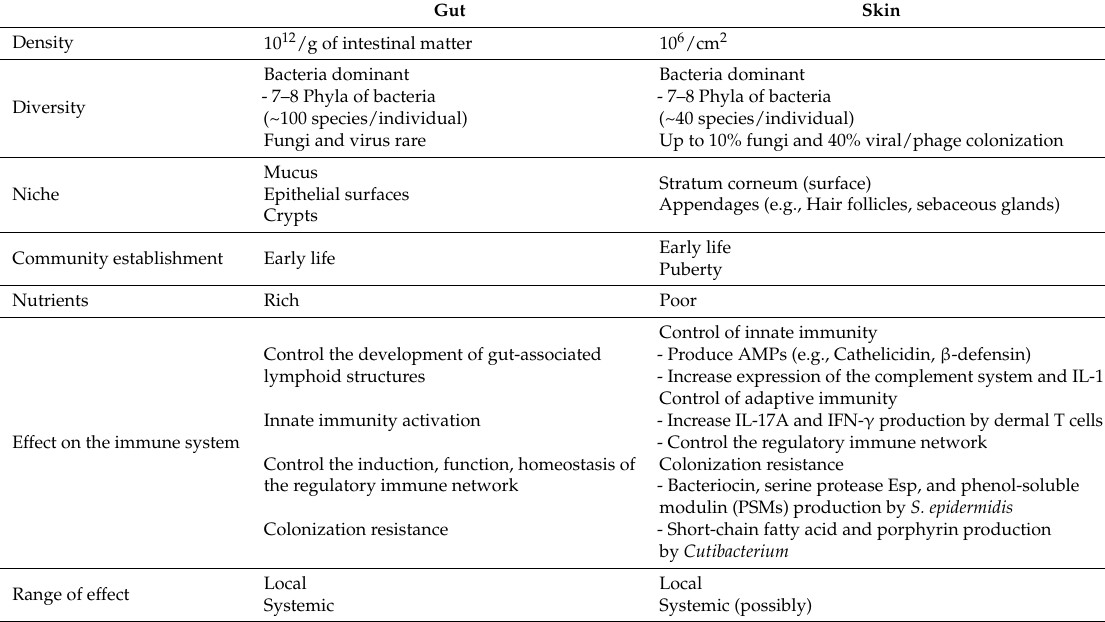
Table 1. Commensal flora of the major human organs [15].